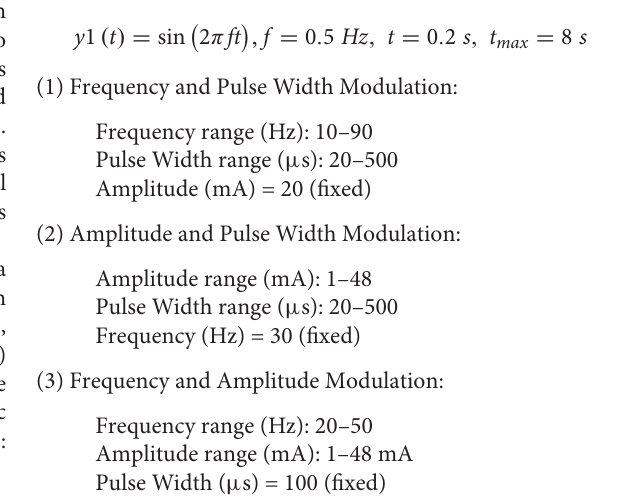
TABLE 3 | Ranges and steps of stimulation parameters used in the characterization measurements. Fixed parameters values